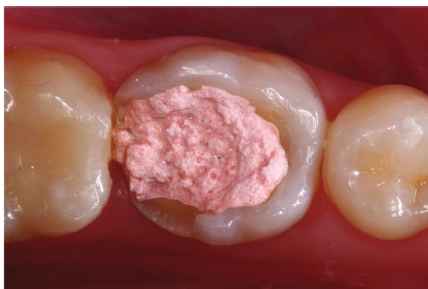
Figure 1: Initial examination of a 23-year-old female patient. A provisional restoration was identified within severely damaged molar (46).